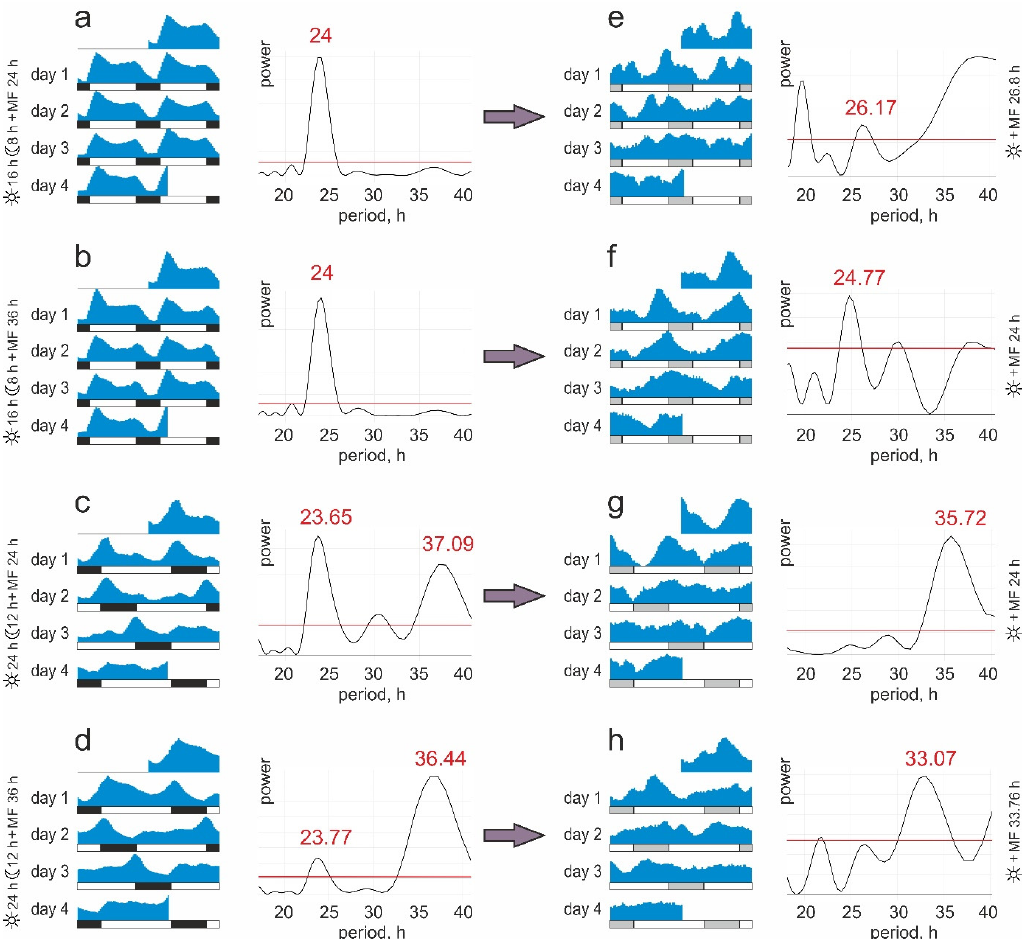
Figure 2. Representative double-plotted actograms and Lomb–Scargle periodograms of gross locomotor activity of zebrafish maintained at different combinations of light regime and magnetic fluctuations (MF). Group #1: ( a ) 16:8 light/dark cycle and 24 h MF at the first stage of experiments with subsequent transfer ( e ) to 26.8 h MF under constant illumination. Group #2: ( b ) 16:8 light/dark cycle and 36 h MF at the first stage with subsequent transfer ( f ) to 24 h MF under constant illumination. Group #3: ( c ) 24:12 light/dark cycle and 24 h MF at the first stage with subsequent transfer ( g ) to 24 h magnetic fluctuations under constant illumination. Group #4: ( d ) 24:12 light/dark cycle and 36 h MF at the first stage with subsequent transfer ( h ) to 33.76 h MF under constant illumination. The bars below the actograms represent the light/dark cycle; open and black bars represent the light and dark phases of the cycle, respectively; open and gray bars represent the light and dark phases of the cycle applied before constant illumination, respectively. Significant peaks ( p < 0.05) exceed the red horizontal line on the periodograms.